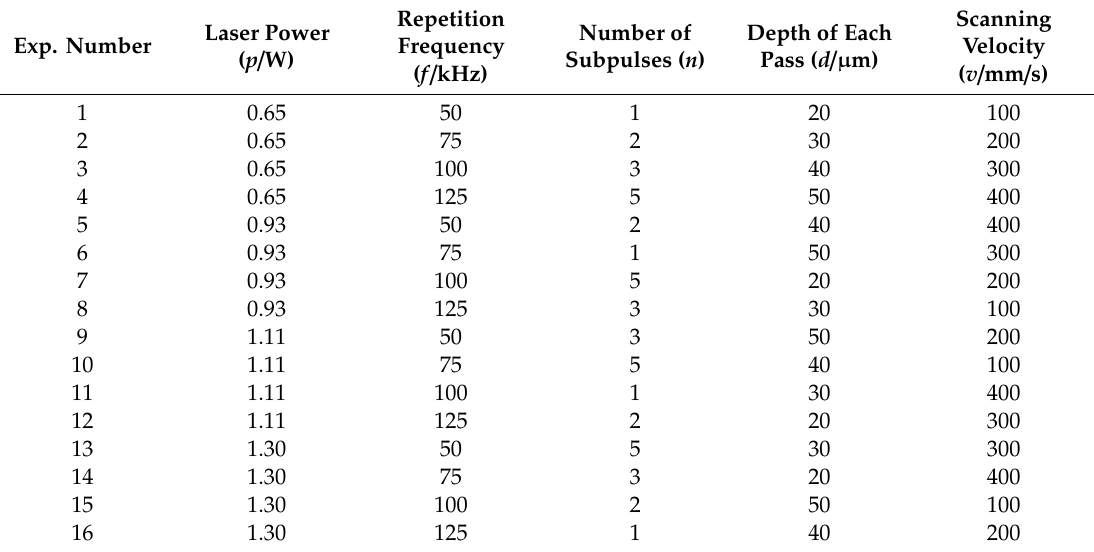
Table 1. Orthogonal-array experimental design of laser-dicing